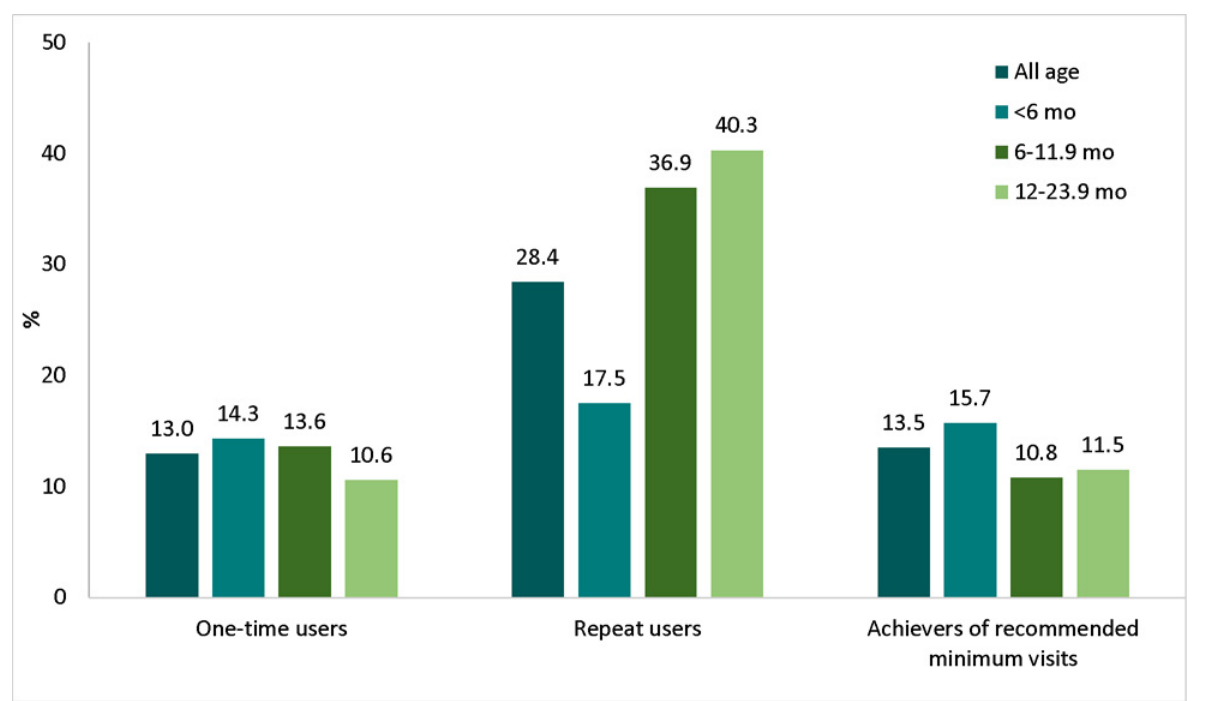
Fig 3. Utilization of IYCF counseling services, by child age